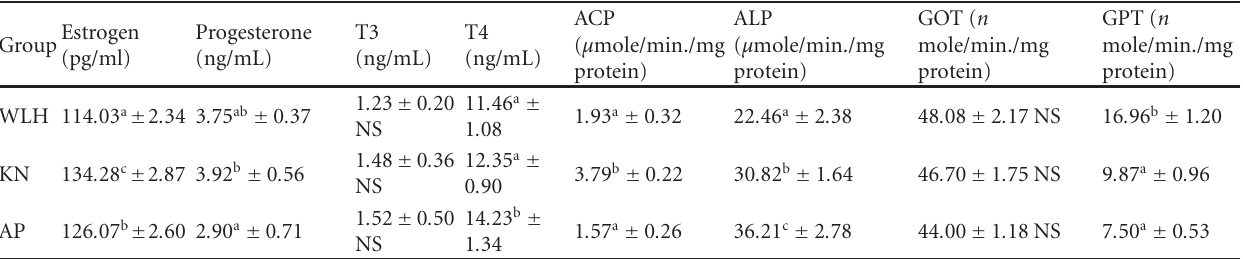
Table 4: Age-dependent variation in hormonal concentration and biochemical constituents of blood plasma (24thwk) in di ff erent breeds of Indian native hen (mean ± S.E.M, n =